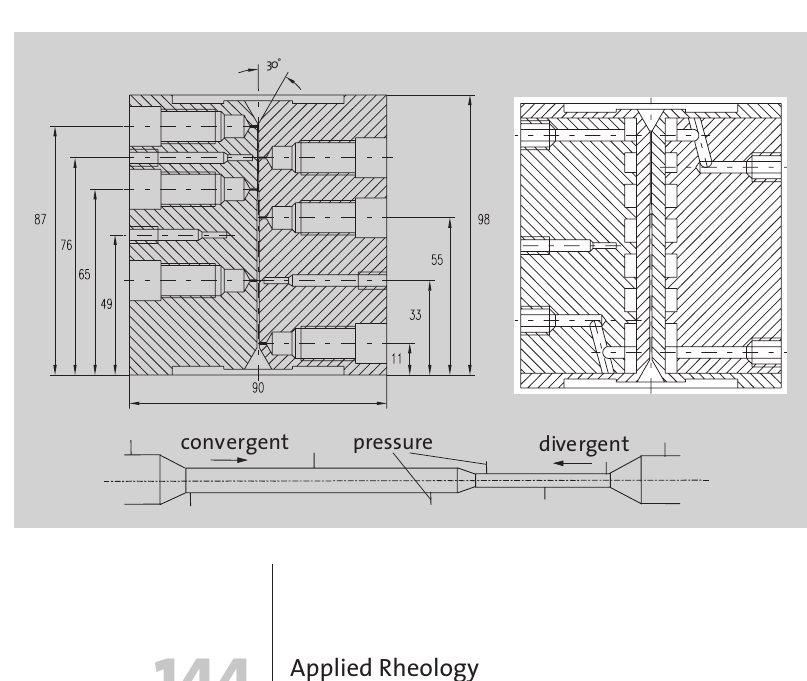
Figure 3 (below): Geometry of the double slit die and of the coolable die as well as their